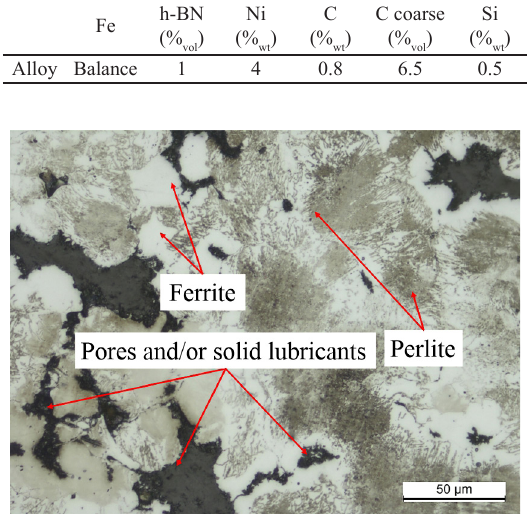
Figure 1. Microstructure of the SP composite.